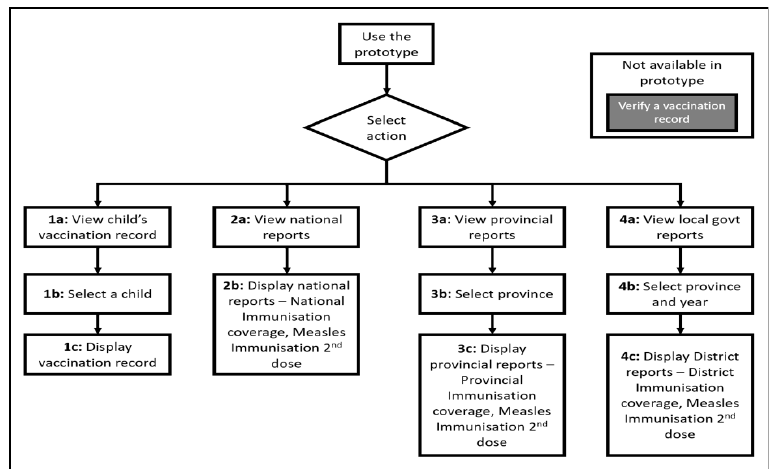
Figure 5: Process flows for doctors